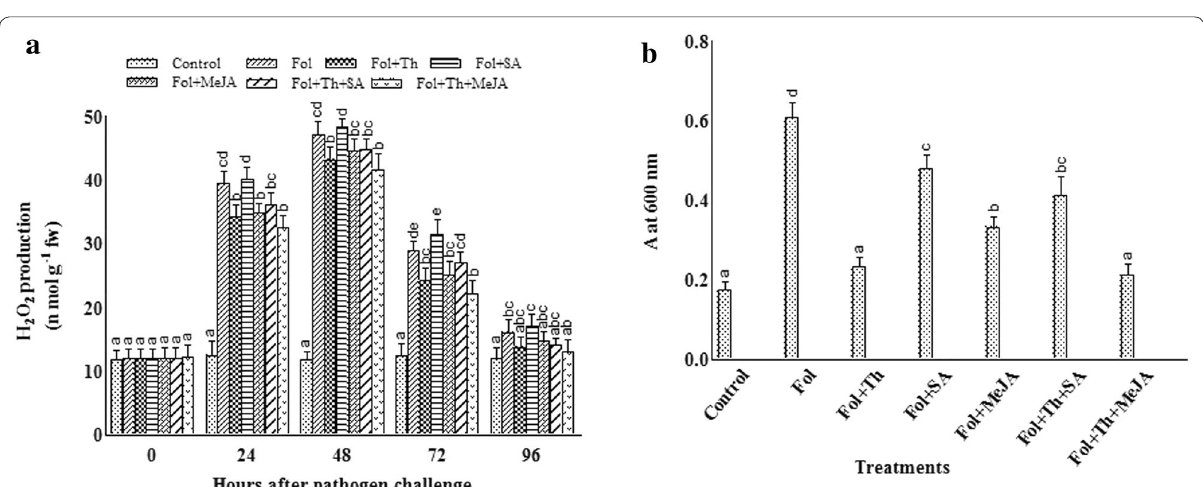
Fig. 3 Estimation of a H 2 O 2 , and b cell death in tomato plants pre-treated with T. harzianum , SA and MeJA either individually or in combination after challenge inoculation with Fusarium oxysporum f. sp. lycopersici (Fol). Results are expressed as the mean of three replicates and vertical bars indicate SD of the mean. Different letters indicate significant differences among treatments within the results taken at the same time interval according to Duncan’s multiple range test at p ≤